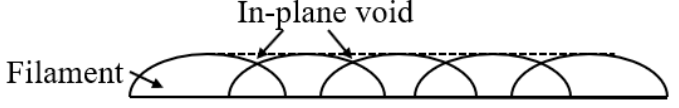
Figure 4. The deposited filament creates in-plane voids.